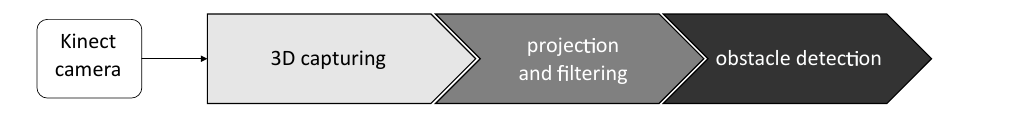
Figure 1. spatial mapping of the current surroundings.